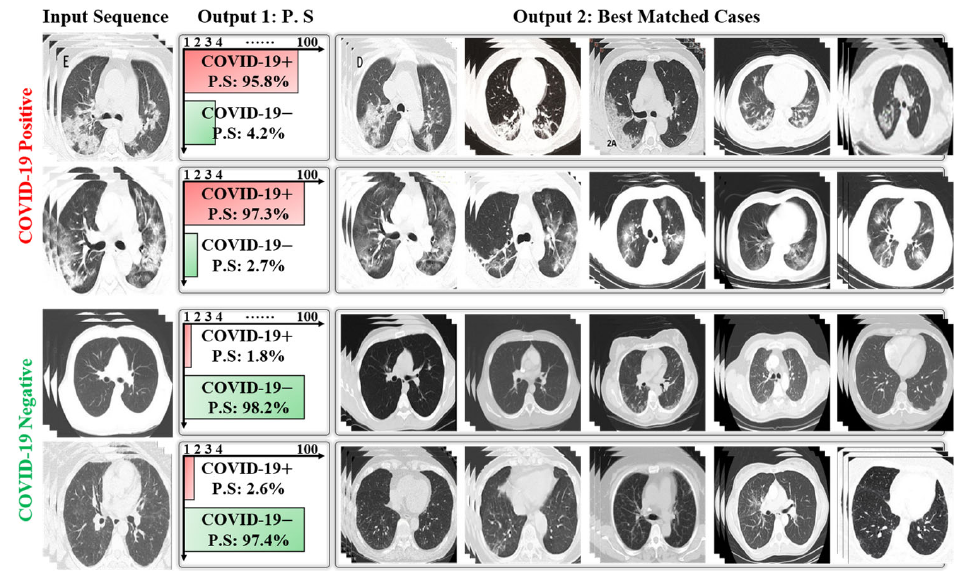
Figure 7. Visualization of predicted outputs of the proposed framework for given data samples including COVID ‐ 19 negative and positive cases (“P.S: Prediction score”).